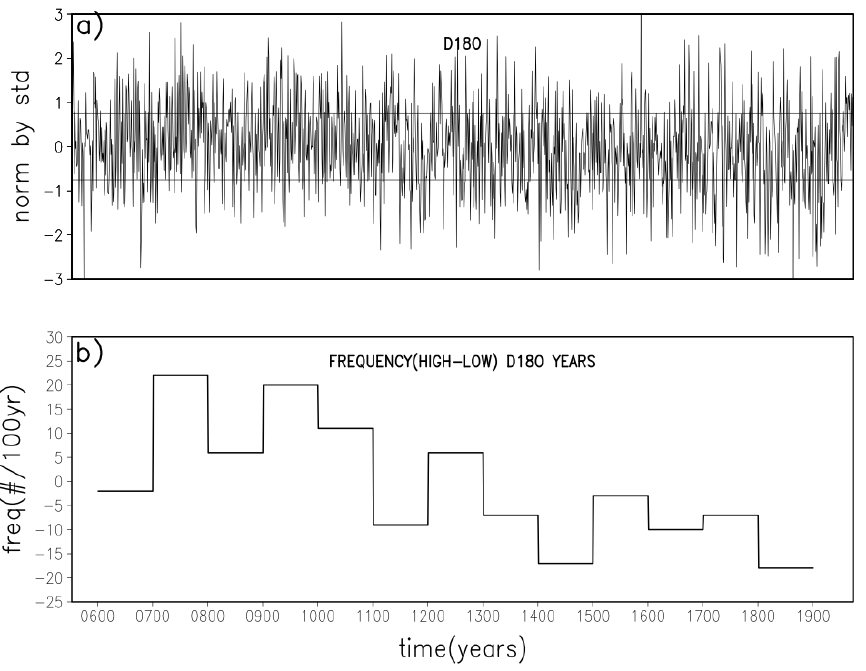
Figure 9. ( a ) The time series of normalized winter Greenland ice core δ 18 O used in this study (see text for details) and ( b ) the difference between the number of years characterized by high (>0.75) and, respectively, low (<( − 0.75)) ice core d δ 18 O in 100-year bins from the year 601 to the year 1900.